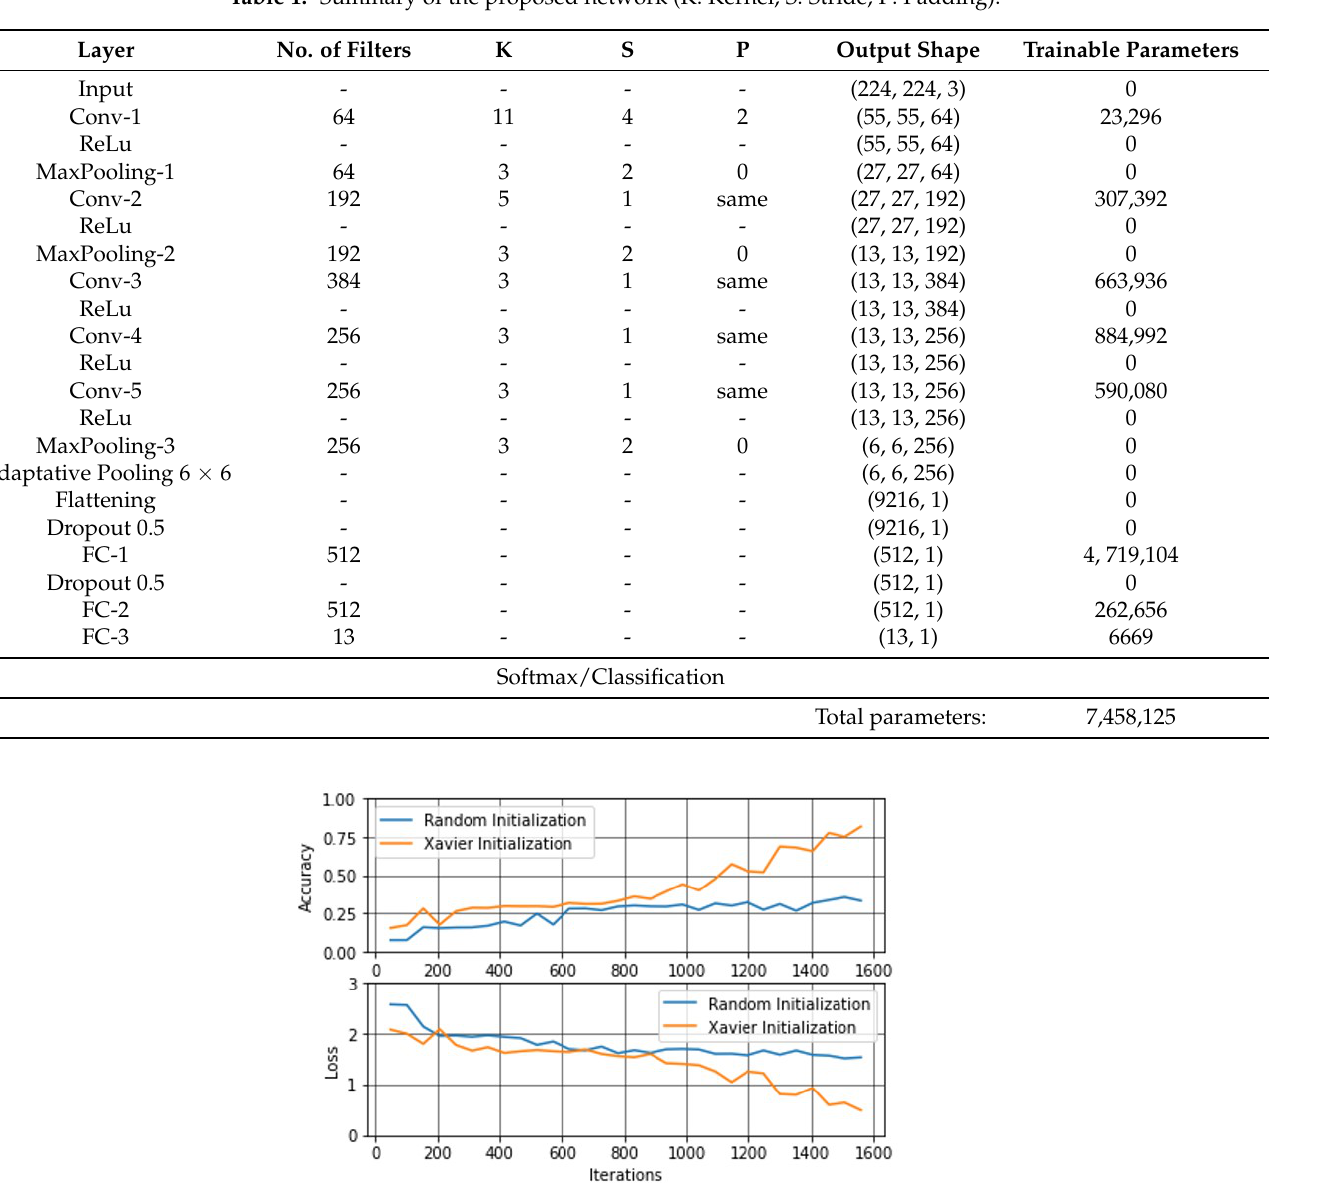
Figure 11. Comparison between training the custom model with randomized weight initialization or Xavier